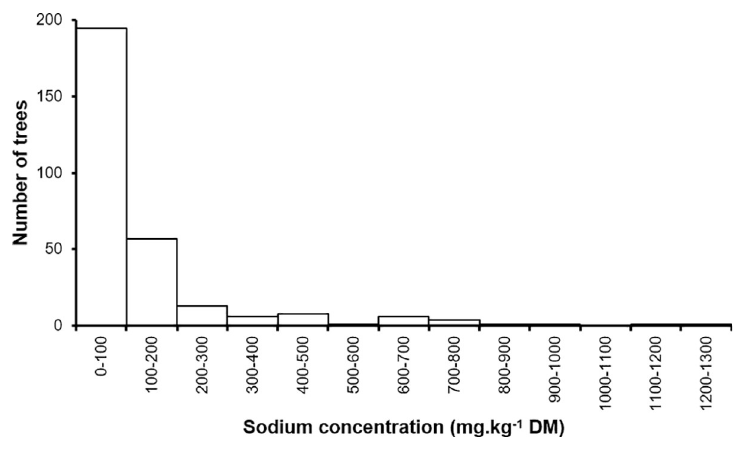
Fig 3. Distribution of sodium concentrations in the bark of 294 unchewed E . mannifera trees.